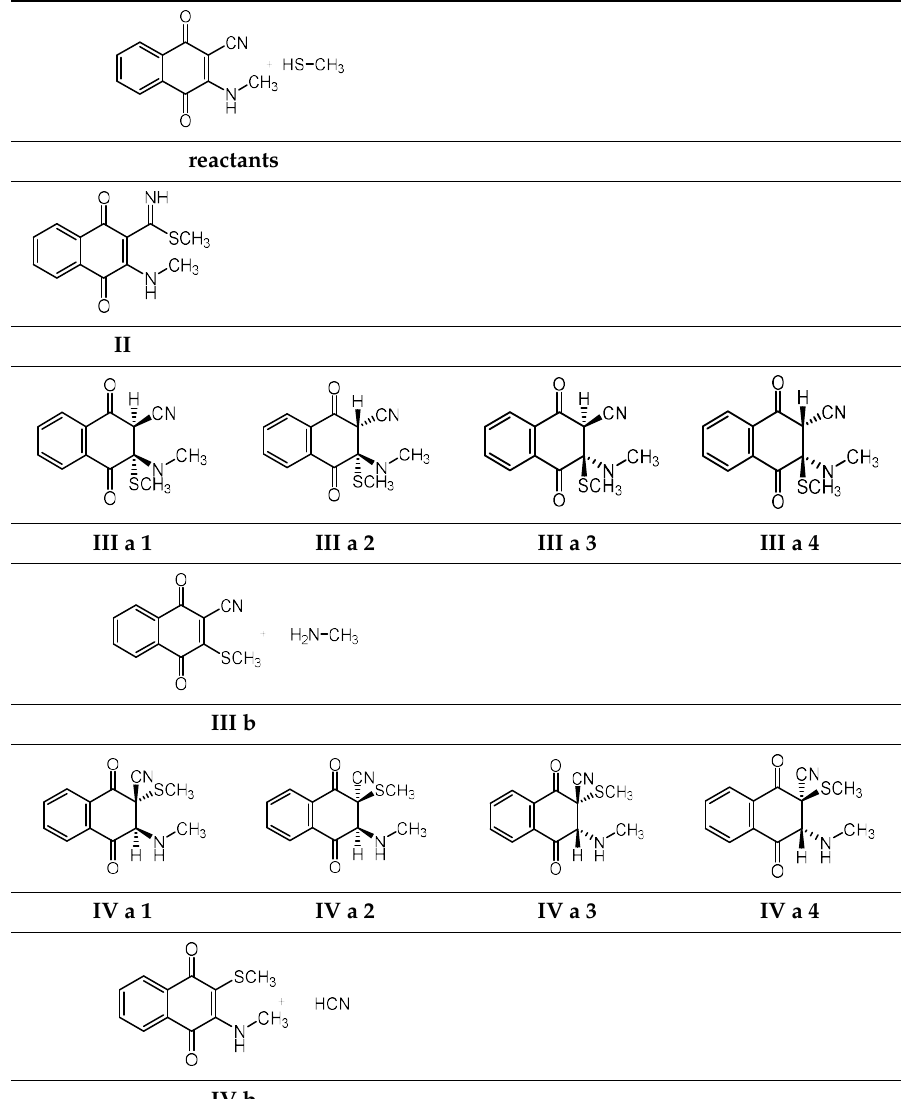
Table 3. Reactants and products of the reaction of methanethiol with the 1,4-naphthoquinones. The corresponding products (except II ) for the chloro-derivatives are obtained by replacing CN by Cl.